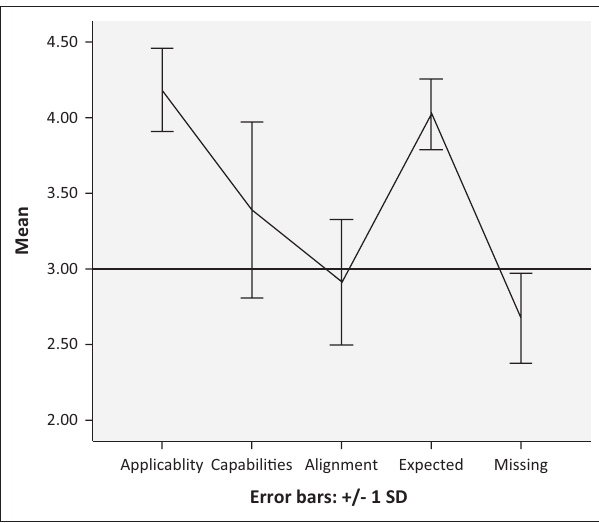
FIGURE 2: Graphical depiction of all variables and overall summary of the implications of findings from the